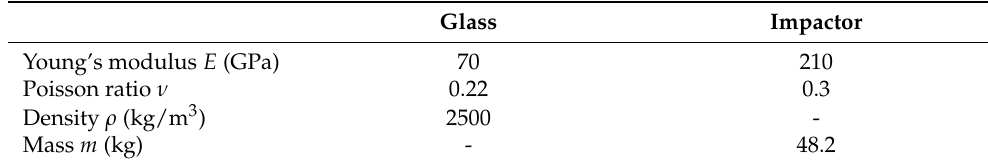
Table 5. Material parameters of float glass and steel impactor.